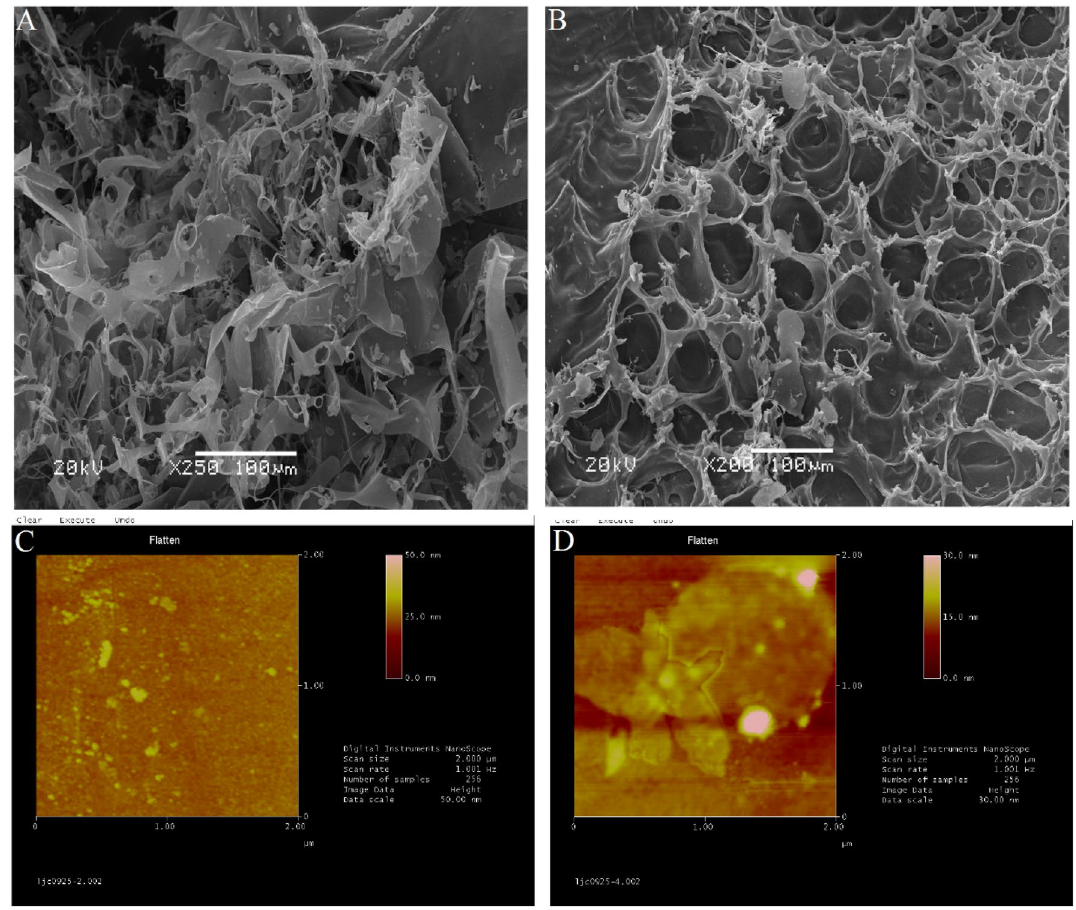
Figure 4. Scanning electron micrographs of Nostoc commune : SEM images of HNCP3 and UNCP4 obtained by JSM-7001E microscope in the scale bar of 100 p. m ( A ) and 10 p. m ( B ); ( C , D ) Atomic force micrographs